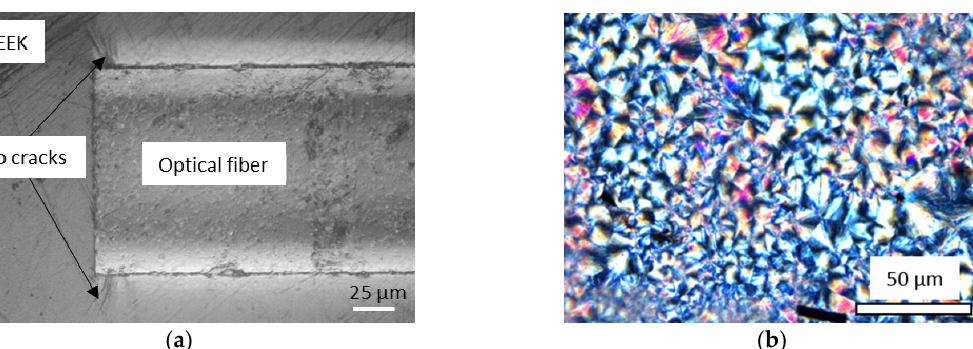
Figure 8. Microsection of the optical fiber embedded into the PEEK polymer ( a ) and PEEK in a petrographic microscope at visible light showing the crystal structure ( b ).